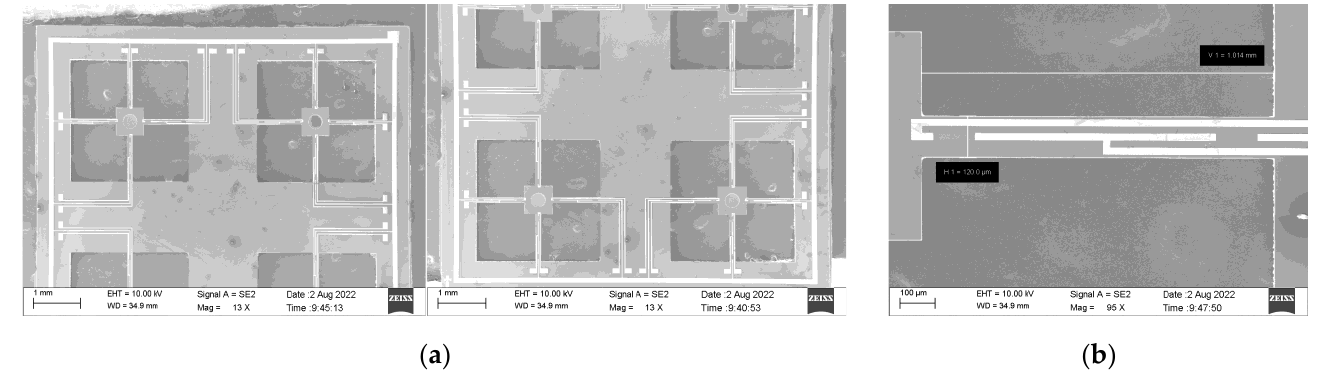
Figure 9. The MEMS process of the FUVH ( a – h ) and ( j ) the view of the A-A section; ( i ) the top view. The specific steps are as follows: (a) prepare a 4-inch SOI wafer; (b) double-sided oxide the SOI; (c) RIE etch the oxide layer and carve out the piezoresistors; (d) use low boron ion implantation to form piezoresistors and anneal repair the damaged lattice; (e) use reoxidation; (f) ICP etch out the ohmic contact area; (g) use high boron ion implanta- tion to form an ohmic contact, and anneal and double-sided deposit the silicon nitride; (h) ICP etch the lead hole, and metal sputter to form conductivity; (i) frontal release the structure; (j) backside release the structure. The completed chip is shown in Figure 10.